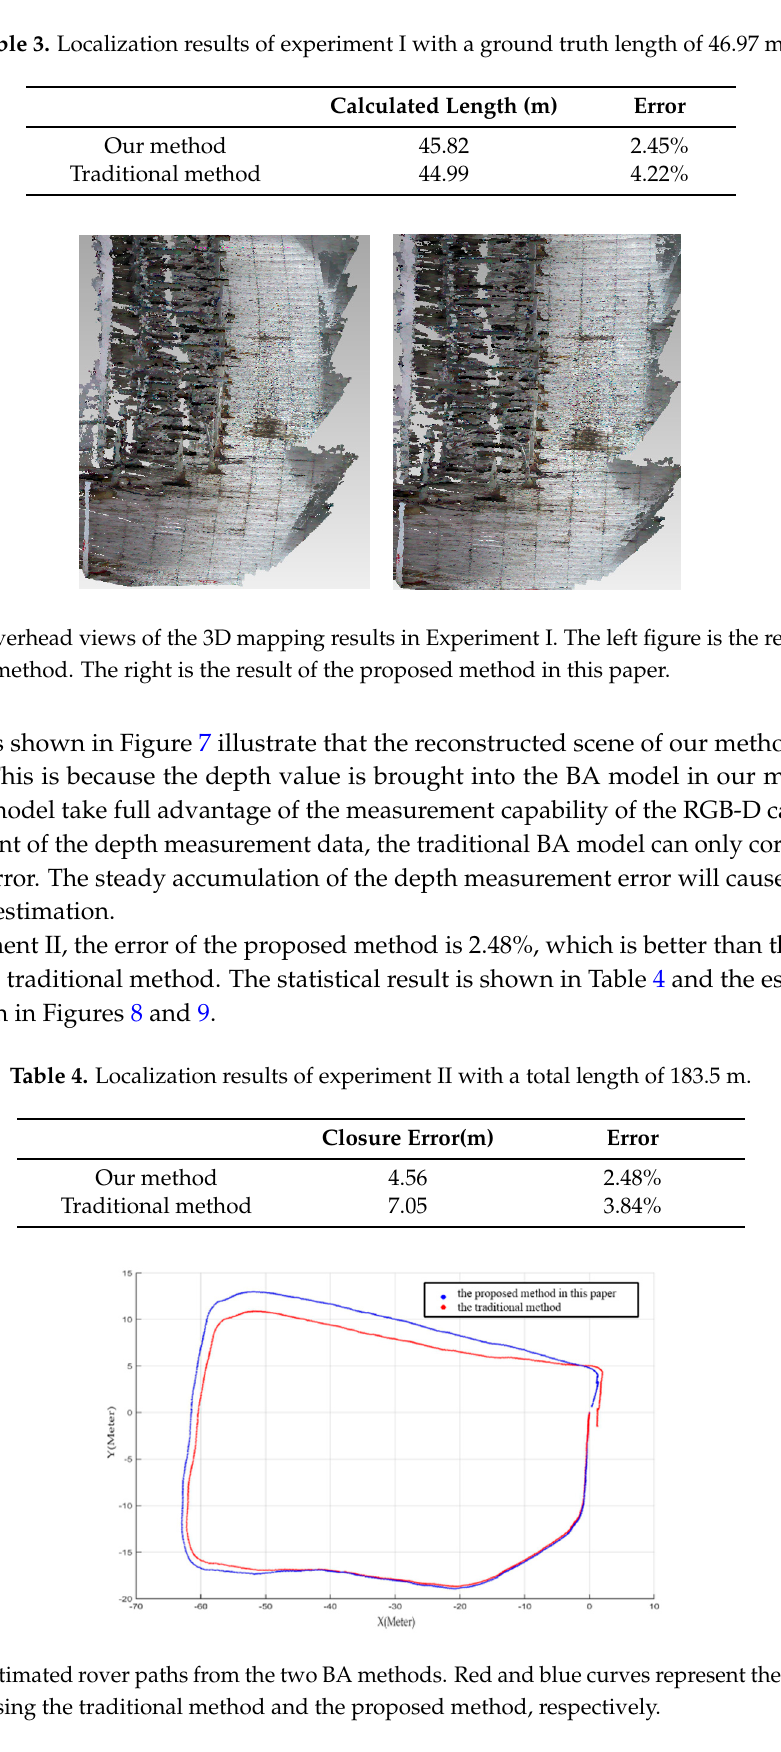
Figure 8. Estimated rover paths from the two BA methods. Red and blue curves represent the estimated trajectory using the traditional method and the proposed method, respectively.